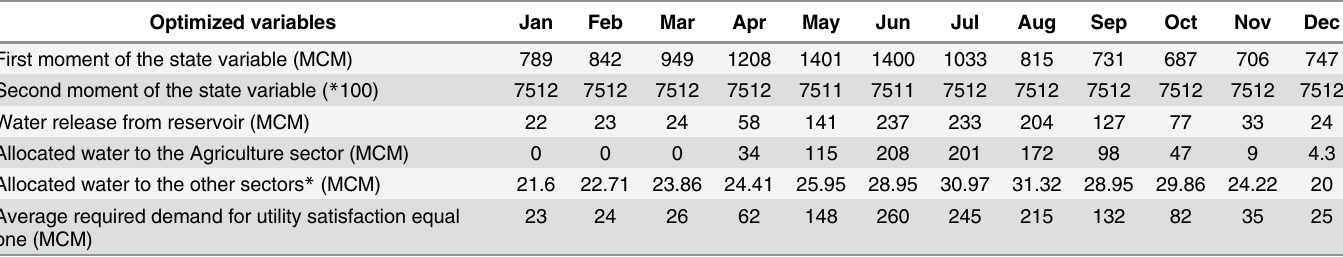
Table 3. The optimized variables resulted from the continuous optimization model based on constrained state formulation. Optimized